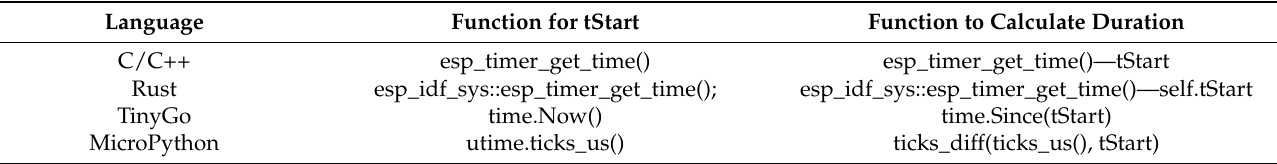
Table 3. Functions and code used to measure execution time in each language.